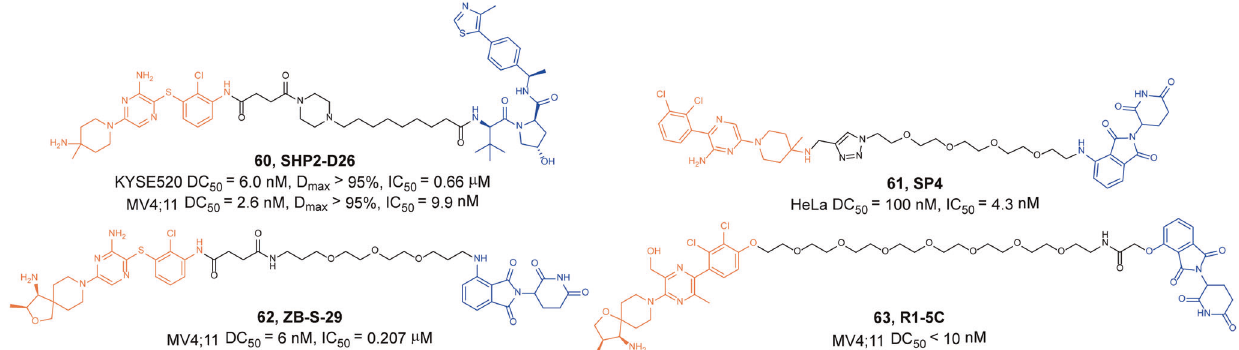
Fig. 17 The representative PROTACs targeting SHP2